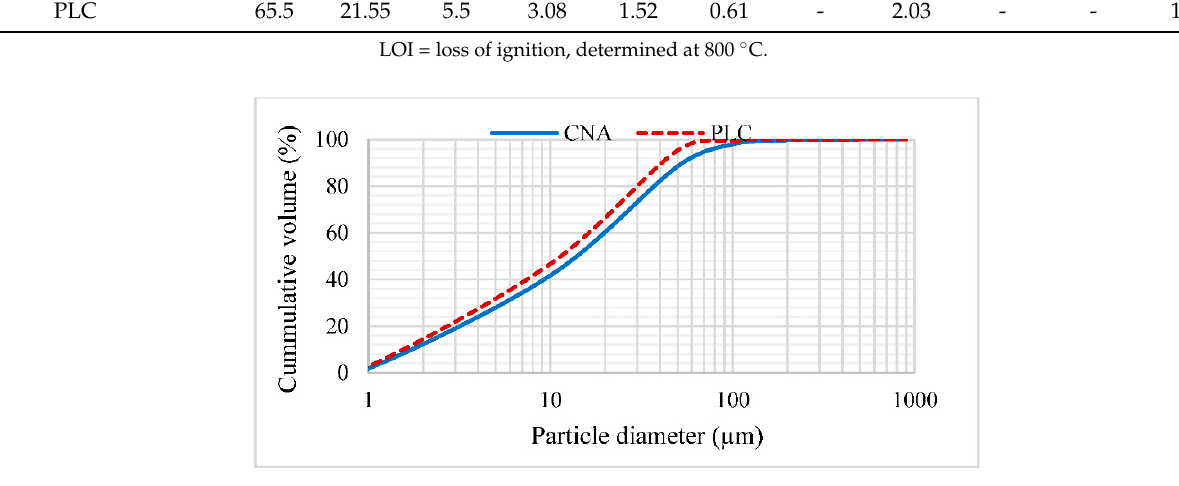
Figure 1. The PSD of binding materials used.